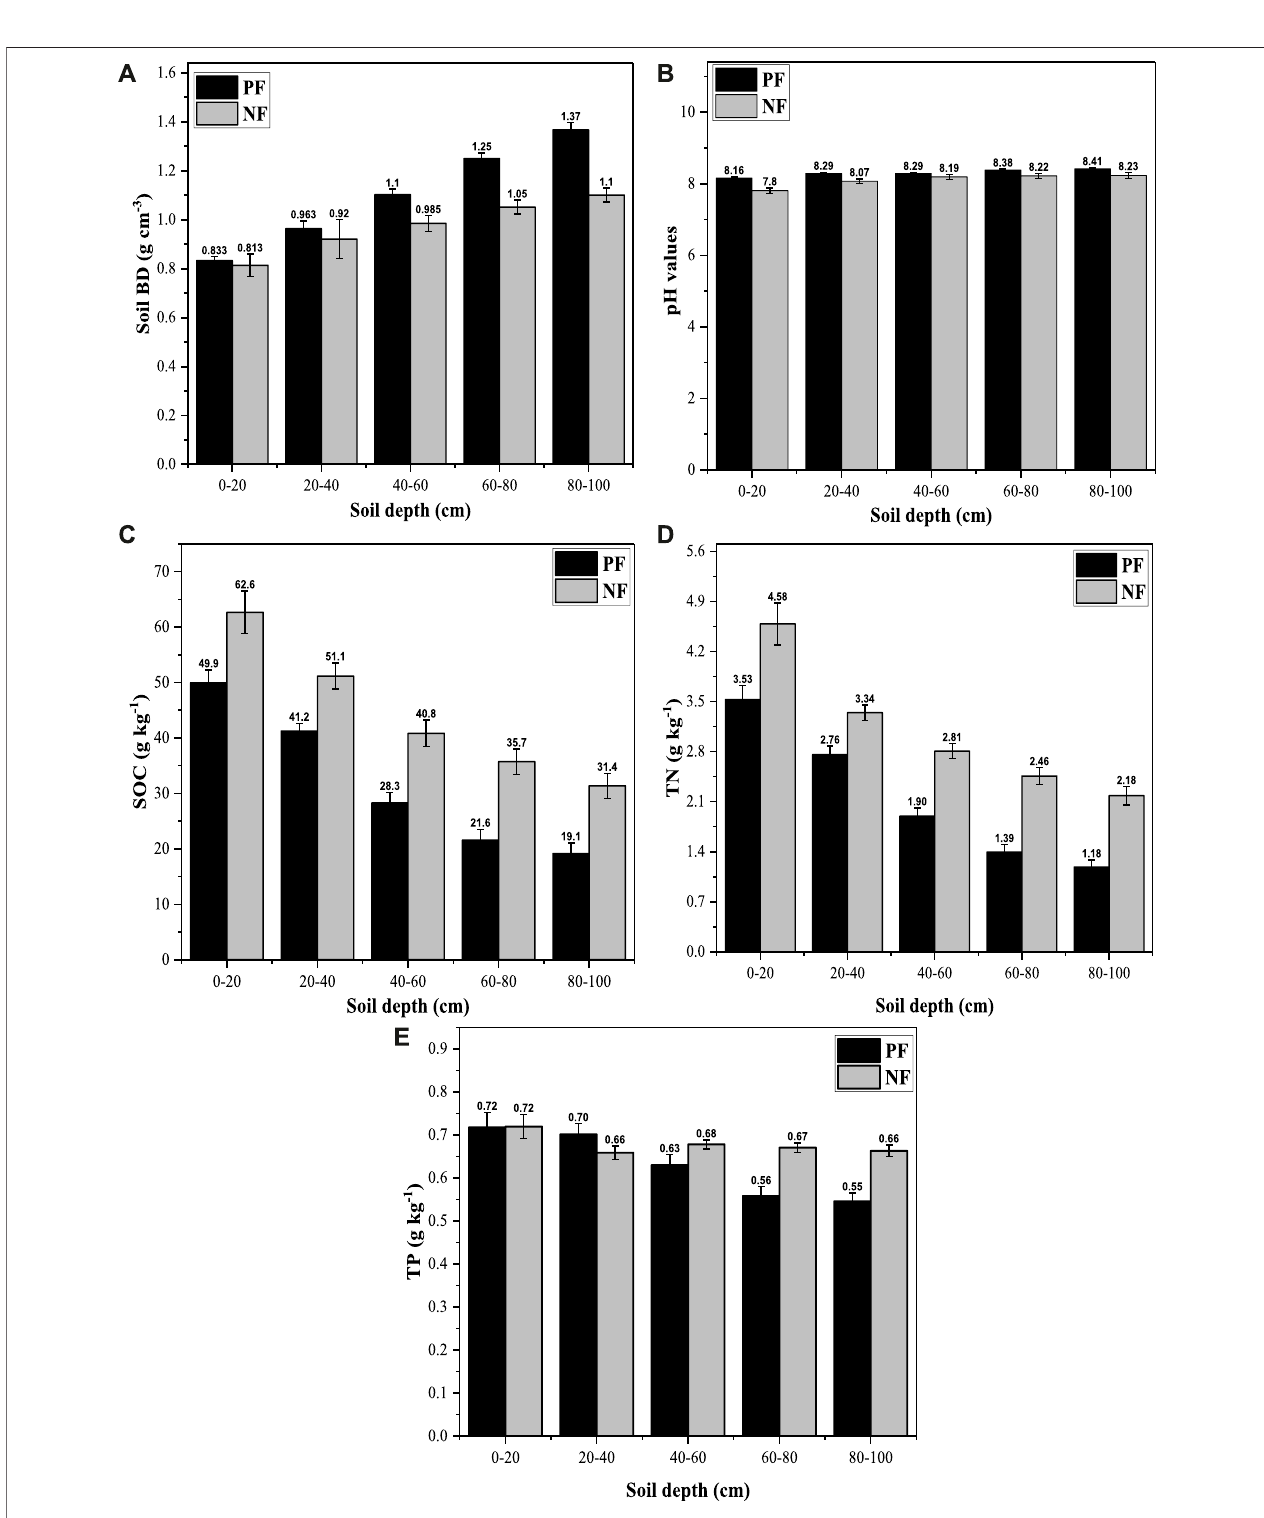
FIGURE 2 | The physicochemical soil properties of different soil depths for PF and NF. The error bars represent standard error. The BD, SOC, TN, and TP indicate the soil bulk density, the contents of soil organic carbon, total nitrogen, and total phosphorus, respectively.